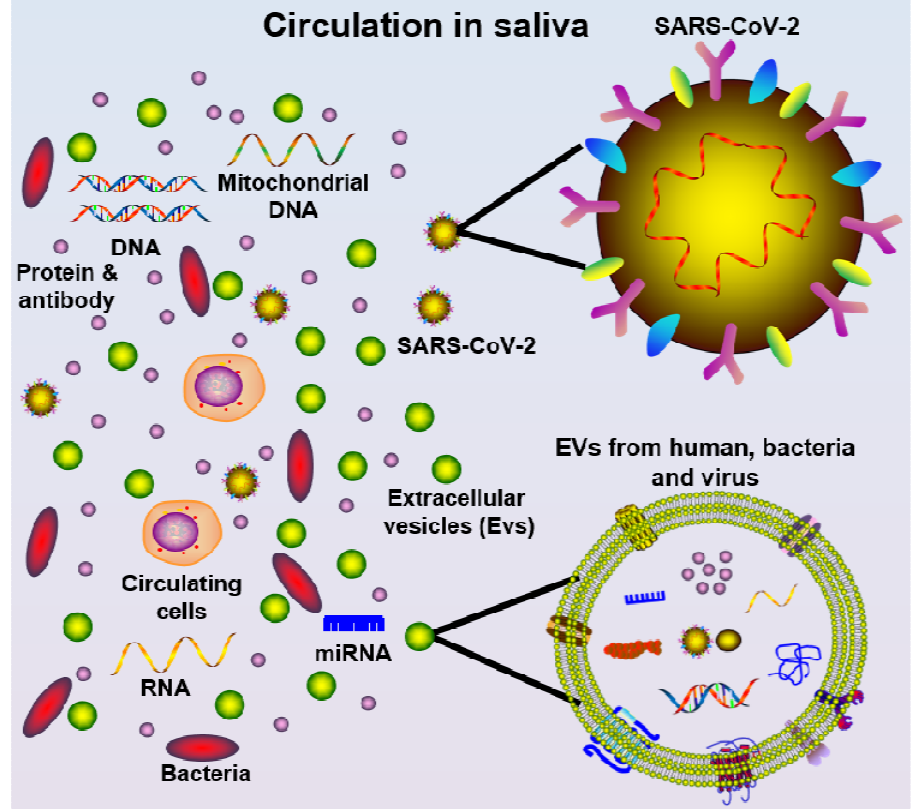
Figure 2. Schematic diagram of saliva components, including cells, mitochondrial DNA, DNA, protein/antibody, bacteria, miRNA, extracellular vesicles (EVs, from multiple oral cavity resident species), and SARS-CoV-2 virus.